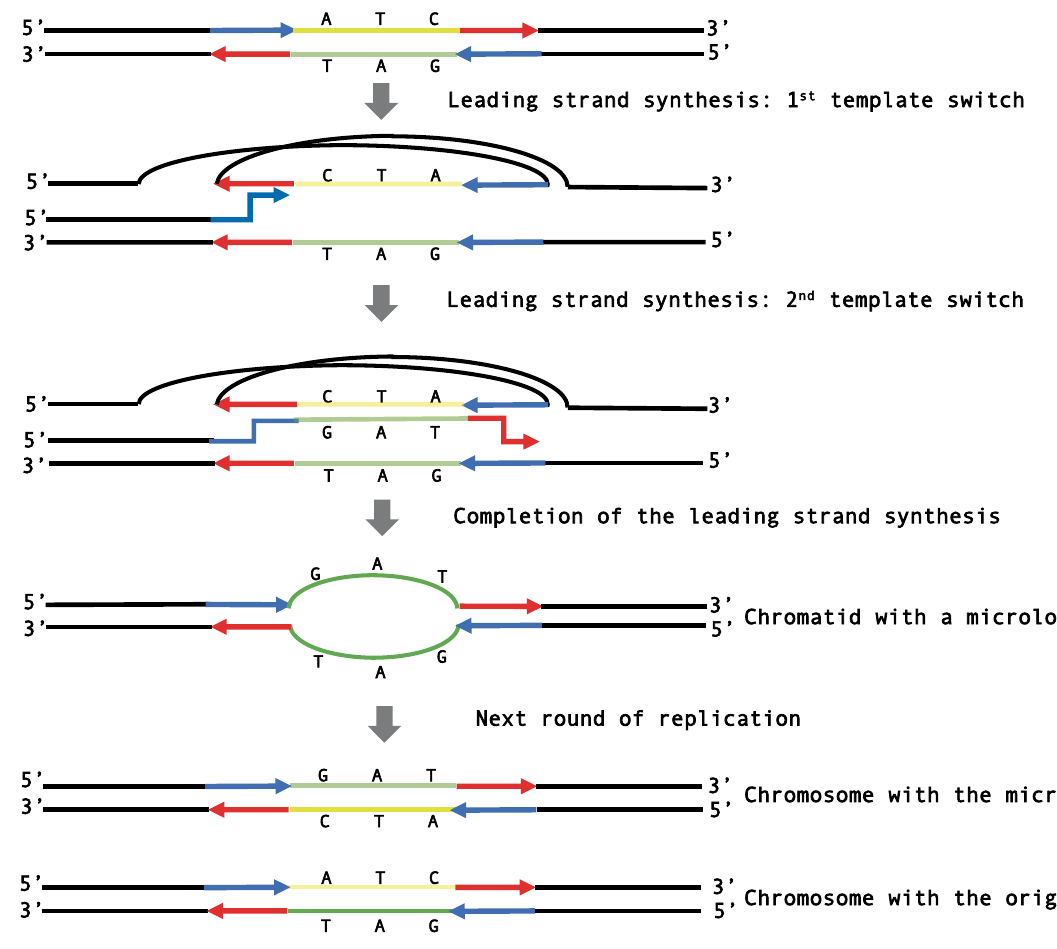
Figure 4. Template-switching model for the formation of microinversions. Complementary strands of a DNA segment to undergo inversion are shown as yellow and green lines. Complementary strands of flanking inverted repeats are shown as red and blue arrows; the tips of these arrows designate 3 ′ ends of inverted repeats (see text for